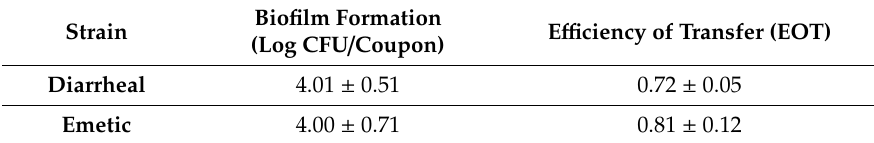
Table 2. Biofilm formation of B. cereus on stainless steel and e ffi ciency of transfer (EOT) from biofilm cells to